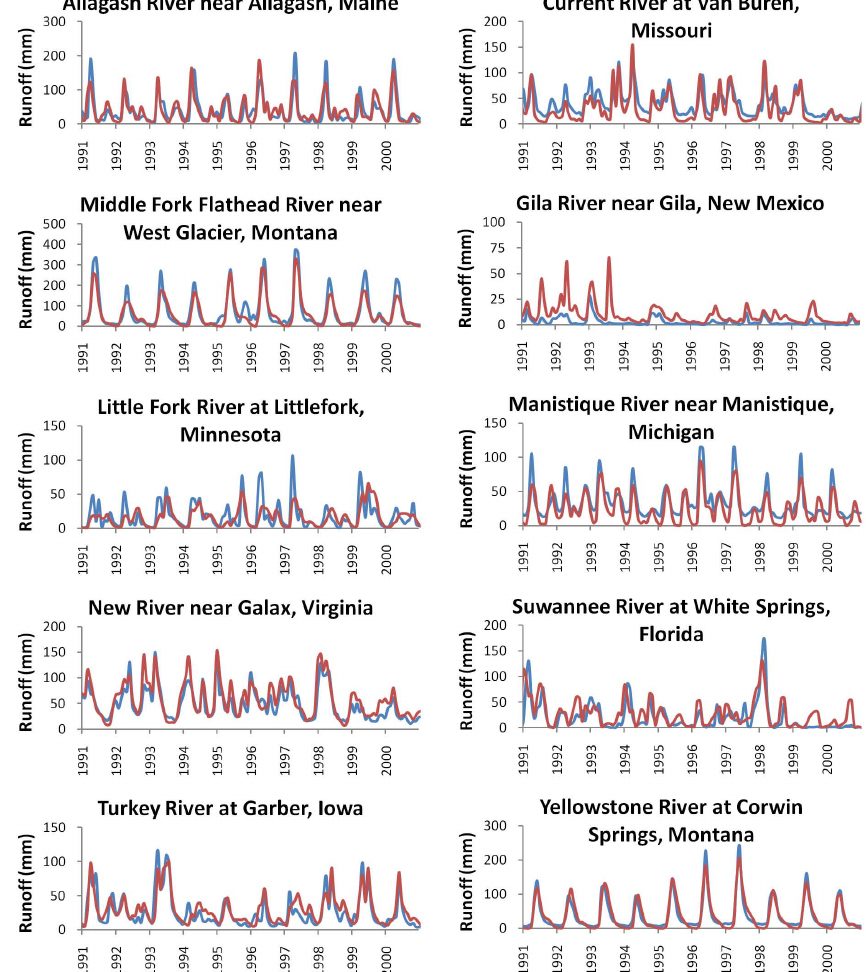
Fig. 3. Time series of observed (blue) and predicted (red) 1991–2000 monthly runoff for the 10 validation